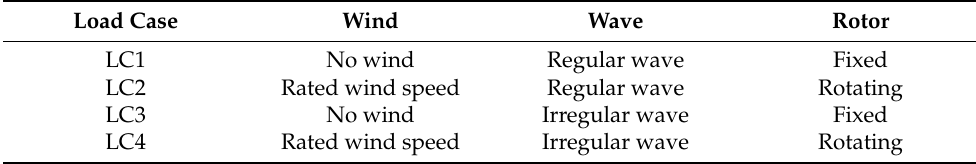
Table 6. Deviation of aerodynamic properties between ideal and real